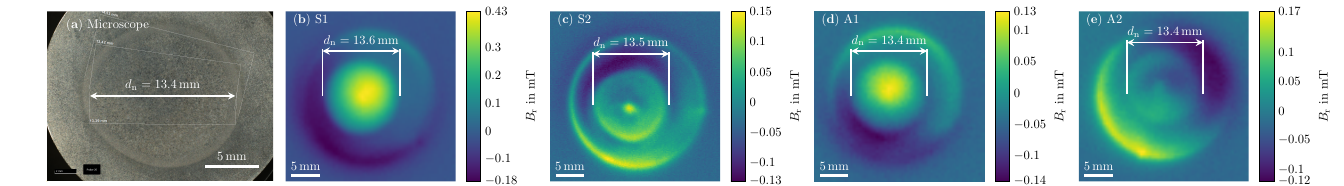
Figure 12. Nugget size d w determined on microscope ( a ) compared with flux density measurements in configurations ( b ) S1, ( c ) S2, ( d ) A1, and ( e ) A2 of magnetized sample 20 of MAT4 ( I mag = 20A).